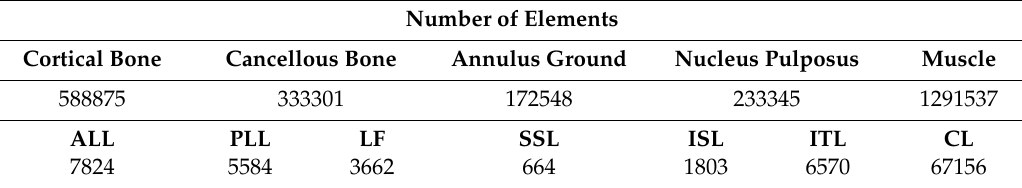
Table 1. Mesh characteristics.